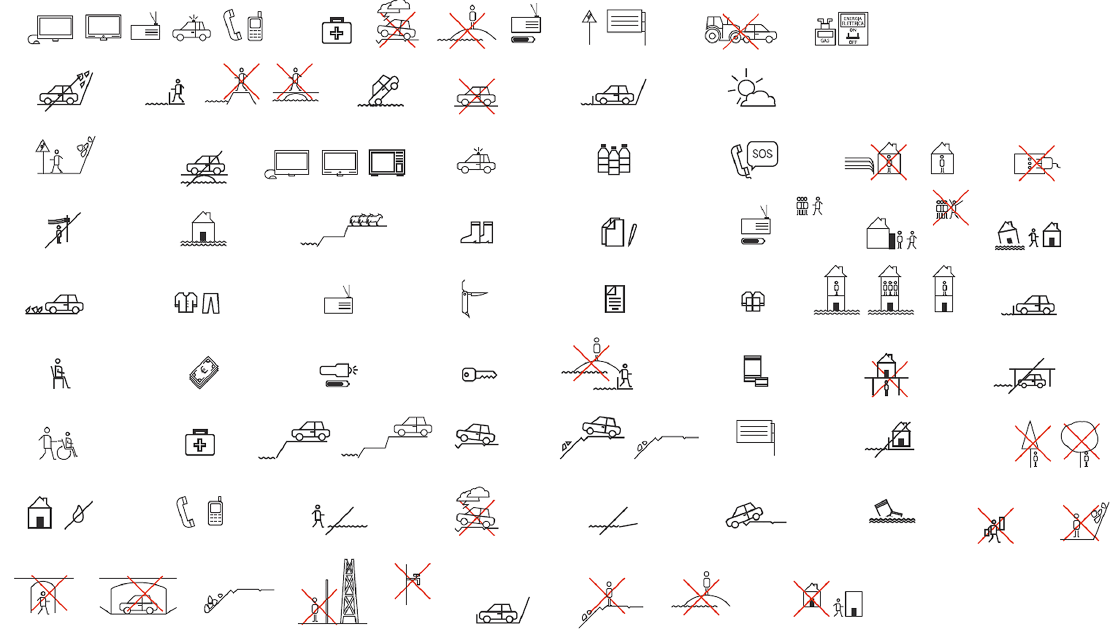
Figure 14. System of graph symbols, proposed in the READY project, for the communication of self-protection behaviour actions in case of